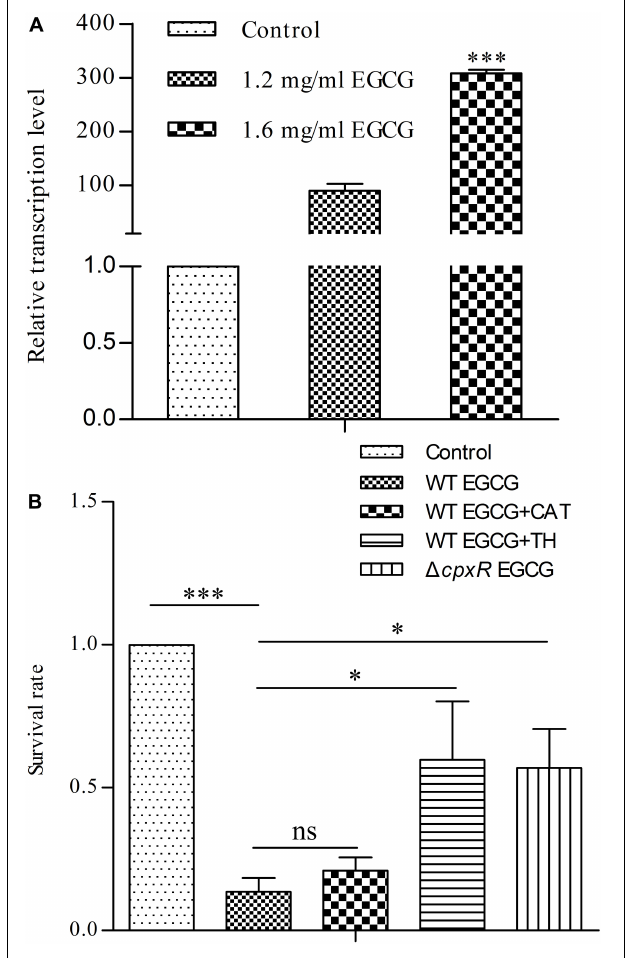
FIGURE 4 | Cpx system activated by EGCG induces cell death. (A) The Cpx system is activated by EGCG. As a control, cells with an OD 600 of 0.5 were cultured for 6 h. y axis was described in Figure 2 . (B) Effects of reactive oxygen species (ROS) on EGCG-mediated cell death. WT EGCG, WT EGCG+CAT, and WT EGCG+TH represent WT exposed to 1.6 mg/ml EGCG, 1.6 mg/ml EGCG plus 20 µ g/ml catalase and 1.6 mg/ml EGCG plus 125 mM thiourea, respectively. (cid:49) cpxR EGCG represents (cid:49) cpxR exposed to 1.6 mg/ml EGCG. Cells without EGCG treatment were used as a control. y axis was described in Figure 3 . All values were obtained from at least three biological replicates. Error bars indicate SD. ∗ P < 0.05; ∗∗∗ P < 0.001. ns, not statistically significant.